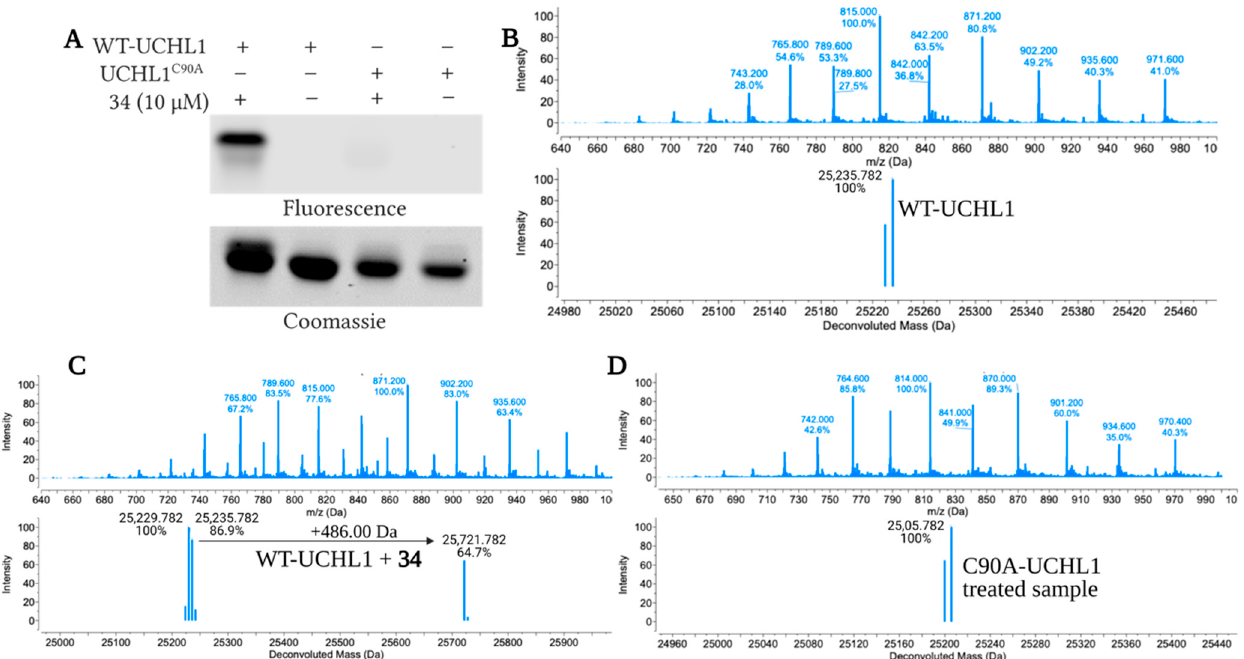
Figure 4. Fluoromethylketone 34 selectively conjugates to the Cys90. ( A ) Recombinant WT-UCHL1 and catalytically inactive C90A mutant followed click reaction with Cy5-Azide and analyzed by in-gel fluorescence shows the alkyne-tagged analog 34 forms a covalent adduct with WT-UCHL1 but does not form an adduct with the catalytically inactive C90A mutant. Coomassie stain provided as loading control. ( B ) Deconvoluted mass spectrum for WT-UCHL1 at 10 µM. ( C ) Deconvoluted mass spectrum for WT-UCHL1 (10 µM) treated with 34 (20 µM). ( D ) Deconvoluted mass spectrum for C90A-UCHL1 (10 µM) treated with 34 (20 µM).